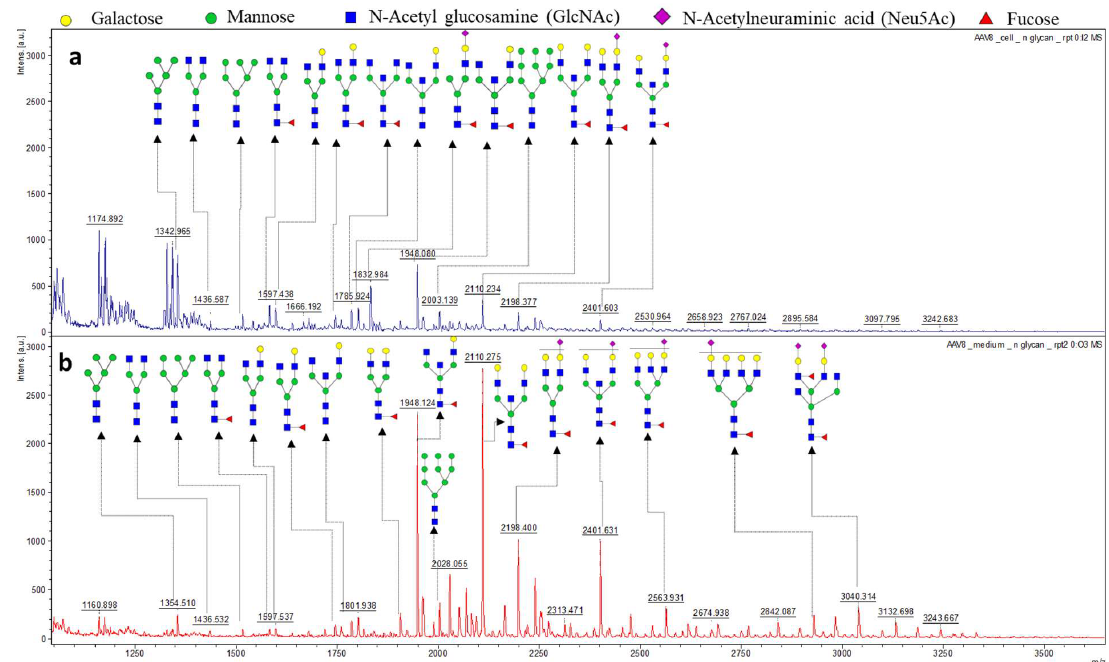
Figure 3. MALDI- MS spectra of 2-AA derived N-glycan in negative mode [M − H] − . ( a ) The whole glycome profile of intracellular AAV8. ( b ) The whole glycome analysis of secreted AAV8. The most intense peaks from both the spectra ( m / z 2110.234, 1948.088, 2401.633, 1832.984 were further confirmed by MS/MS fragmentation spectra in MALDI-TOF MS in lift mode (supplemental Figure S2).